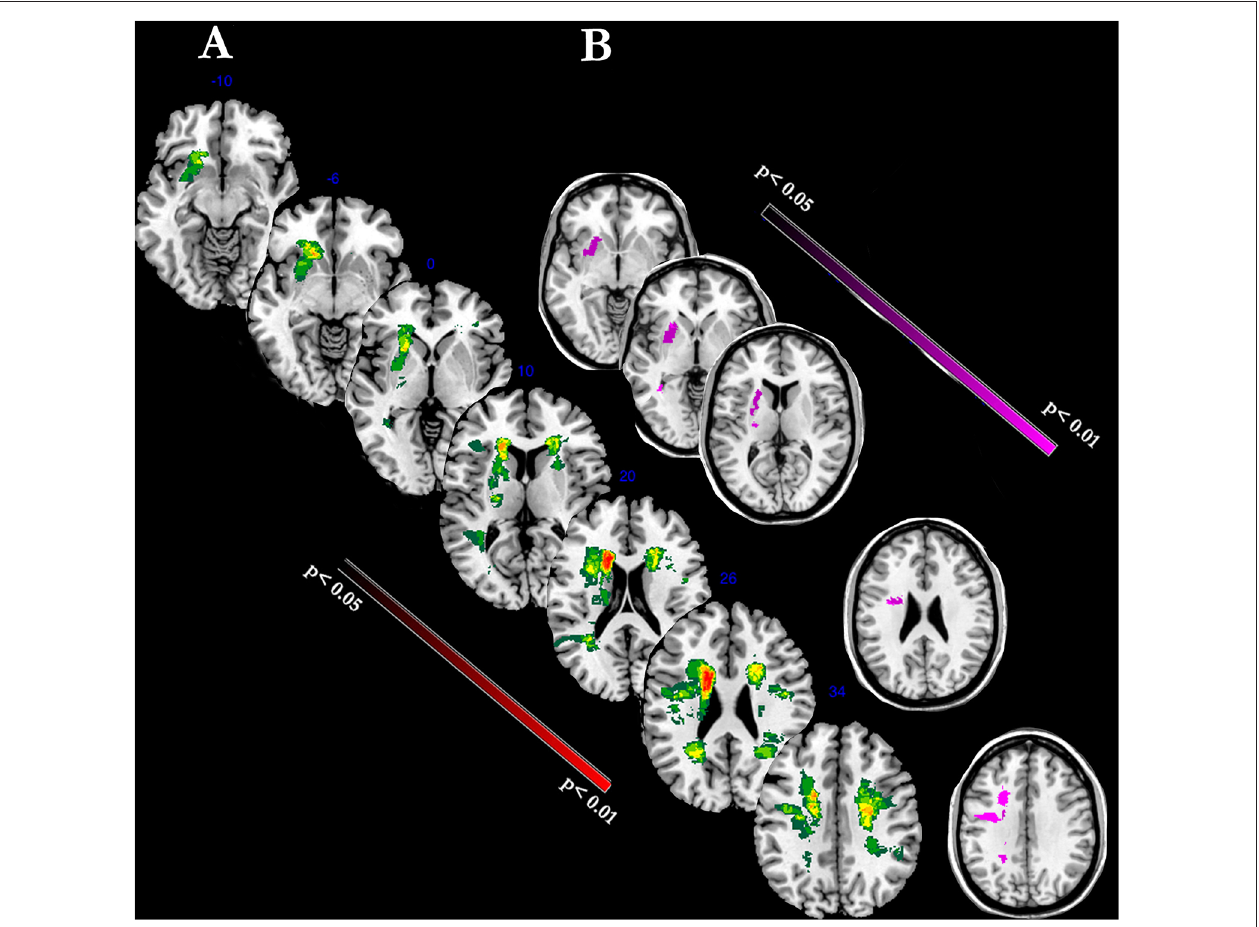
FIGURE 4 | The figure represents voxel-level lesion-mapping analysis performed with voxel-based lesion symptom mapping (VLSM) method implemented in the nonparametric mapping (NPM) software included into the MRIcron software (A) . Overlay of FLAIR-dependent MRI lesions detected in all stroke patients ( n = 14). The color indicates the frequency of overlapping stroke-related lesions (maximal: red blobs). (B) Regression Analysis: Voxels within the superior region of the corona radiata, internal capsule and putamen were significantly correlated with the degree of motor recovery as assessed by FM-UE scale (violet blobs; P <